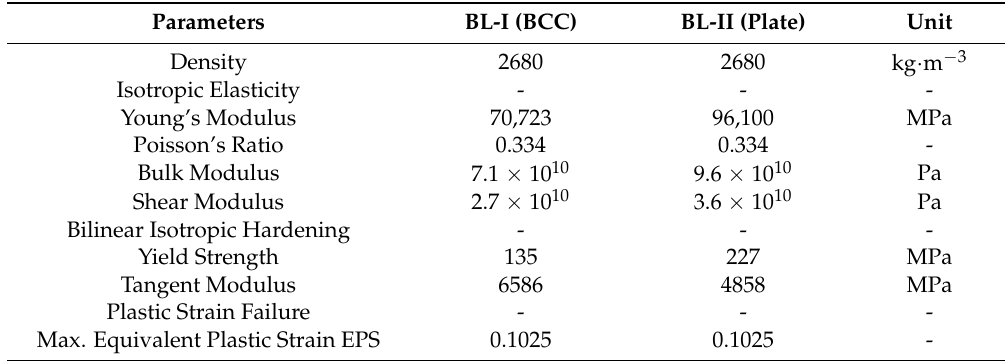
Table 7. Materials model used for lattice structure specimens